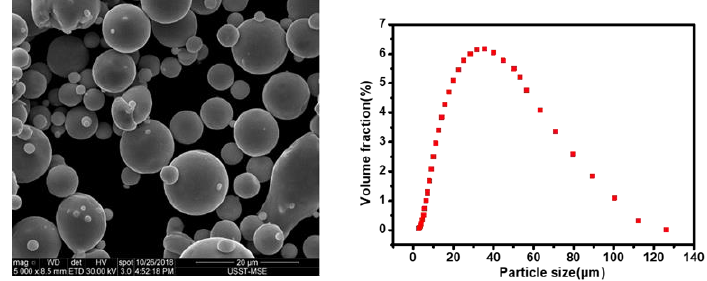
Figure 1. SEM micrograph and particle size distribution of raw Cu–Cr–Zr alloy powder.